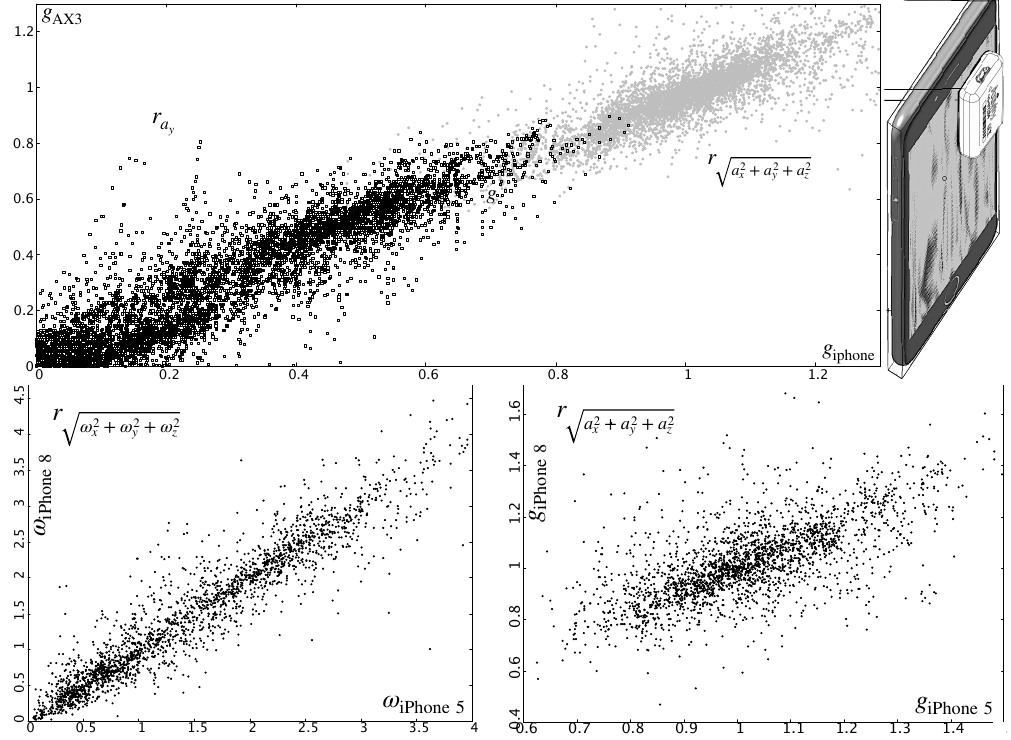
Figure 4. Top: Correlation (for the y -component and the vector norm, respectively) between the accelerometer in an iPhone 5 model and a dedicated AX3 sensor (during a 20 m shikko track). Bottom: Comparison of the norms of the gyro ( ω ) and acceleration ( a ) information as measured by two different smartphone models (iPhone 5 and 8) and for the same movement (a similar shikko